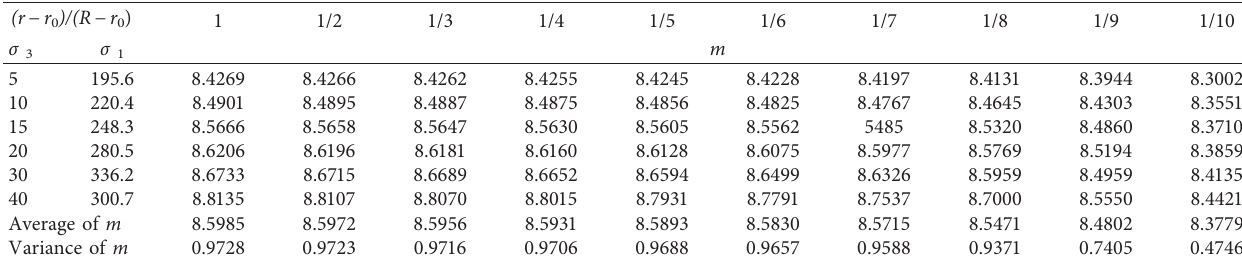
Table 5: The value of m in the specimen with an aperture of 20mm.